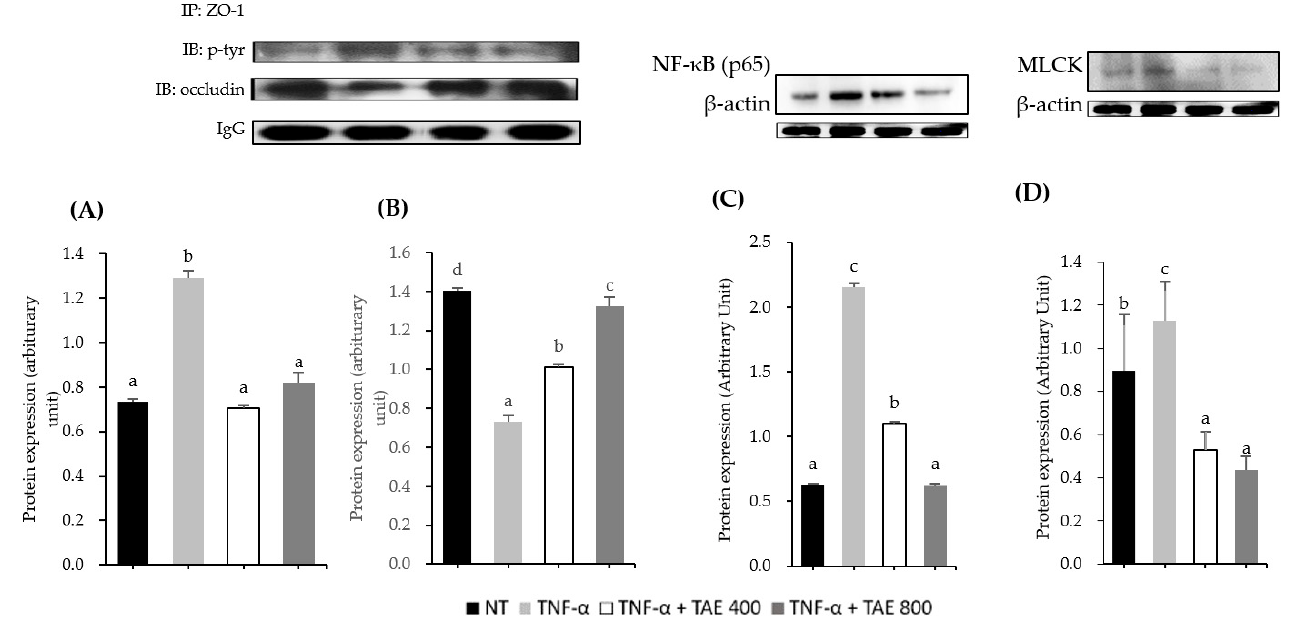
Figure 3. Effect of thinned apple extract (TAE) on tyrosine phosphorylation of ZO-1 and the interaction between the ZO-1 andoccludin in Caco-2 cells. ( A ) The protein level of tyrosine phosphorylation ( p -tyr) and ( B ) occludin that immunoprecipitated with ZO-1. The protein level of ( C ) p65 and ( D ) myosin light chain kinase (MLCK) in Caco-2 cells. Data are expressed as mean ± SD ( n = 3–6). Different letters indicate significant differences according to Duncan’s multiple range test ( p < 0.05).